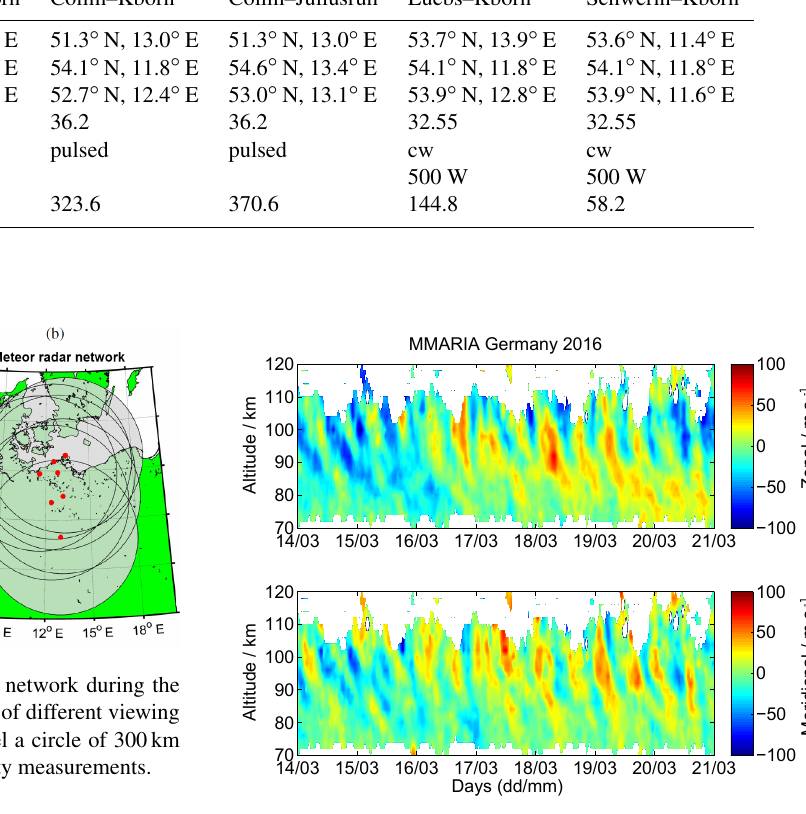
Figure 11. Overview of zonal and meridional wind components ap- plying the standard wind analysis to the MMARIA network during the March 2016